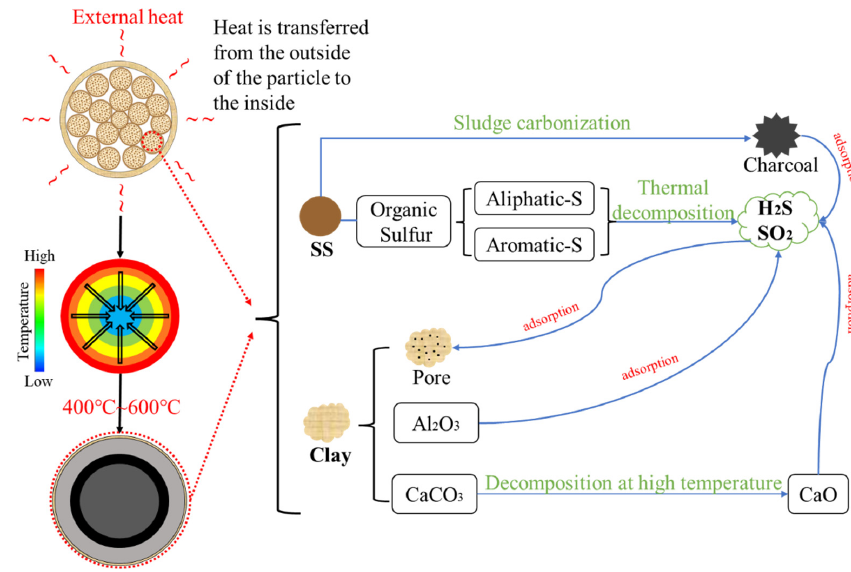
Figure 7. Inhibition of sulfur-containing-gas release process by SS-C composite